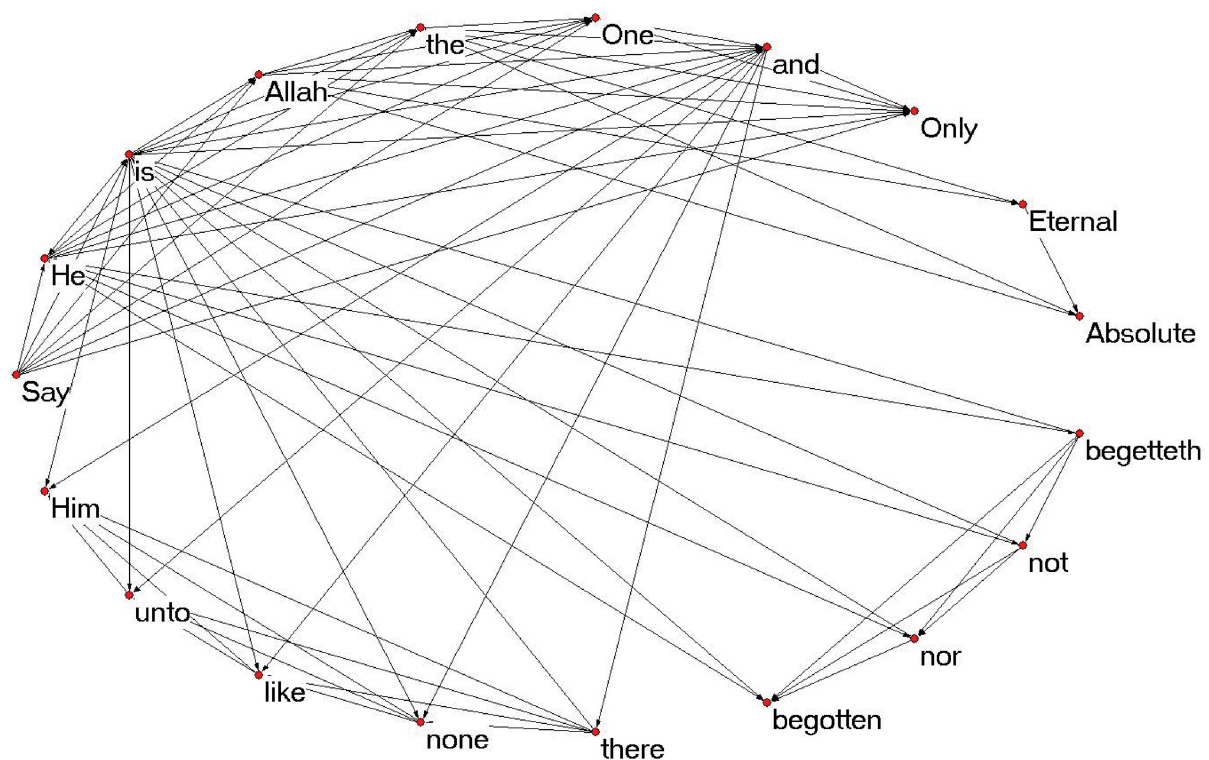
Fig 1. Network example: “Yousif Ali” for chapter 112, nodes represent the words, directed edge represents “occurring-before” relationship.